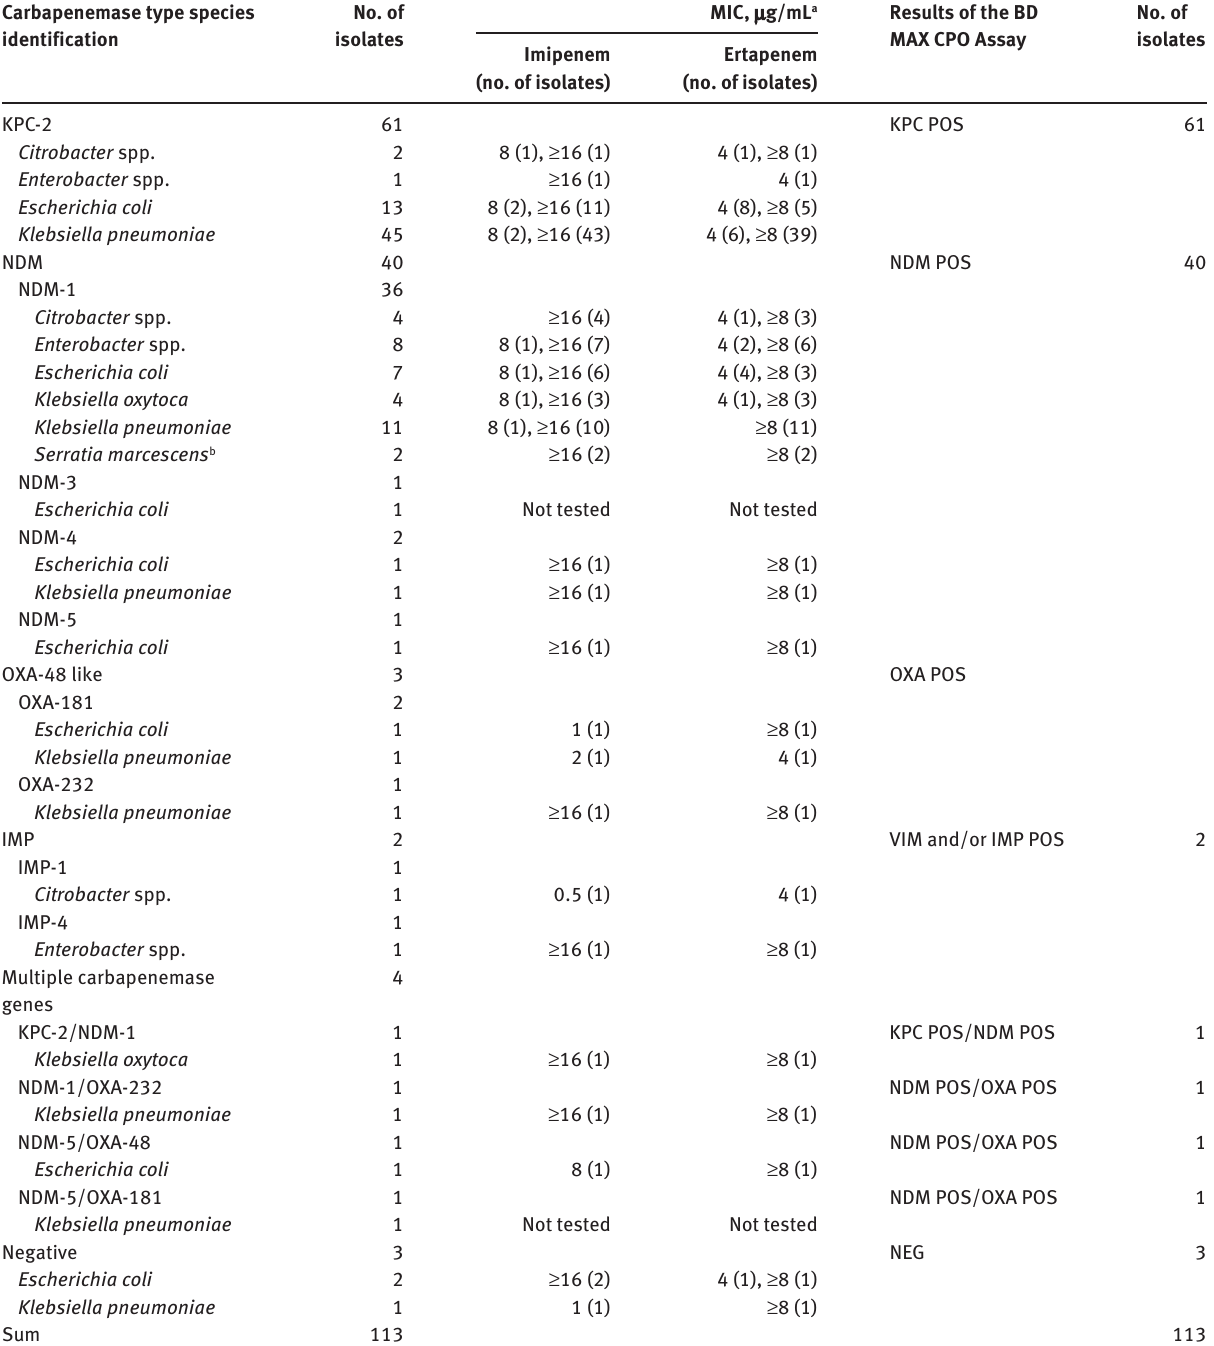
Table 1: Bacterial isolates used for the evaluation of the BD MAX Check-Points CPO Assay. Carbapenemase type